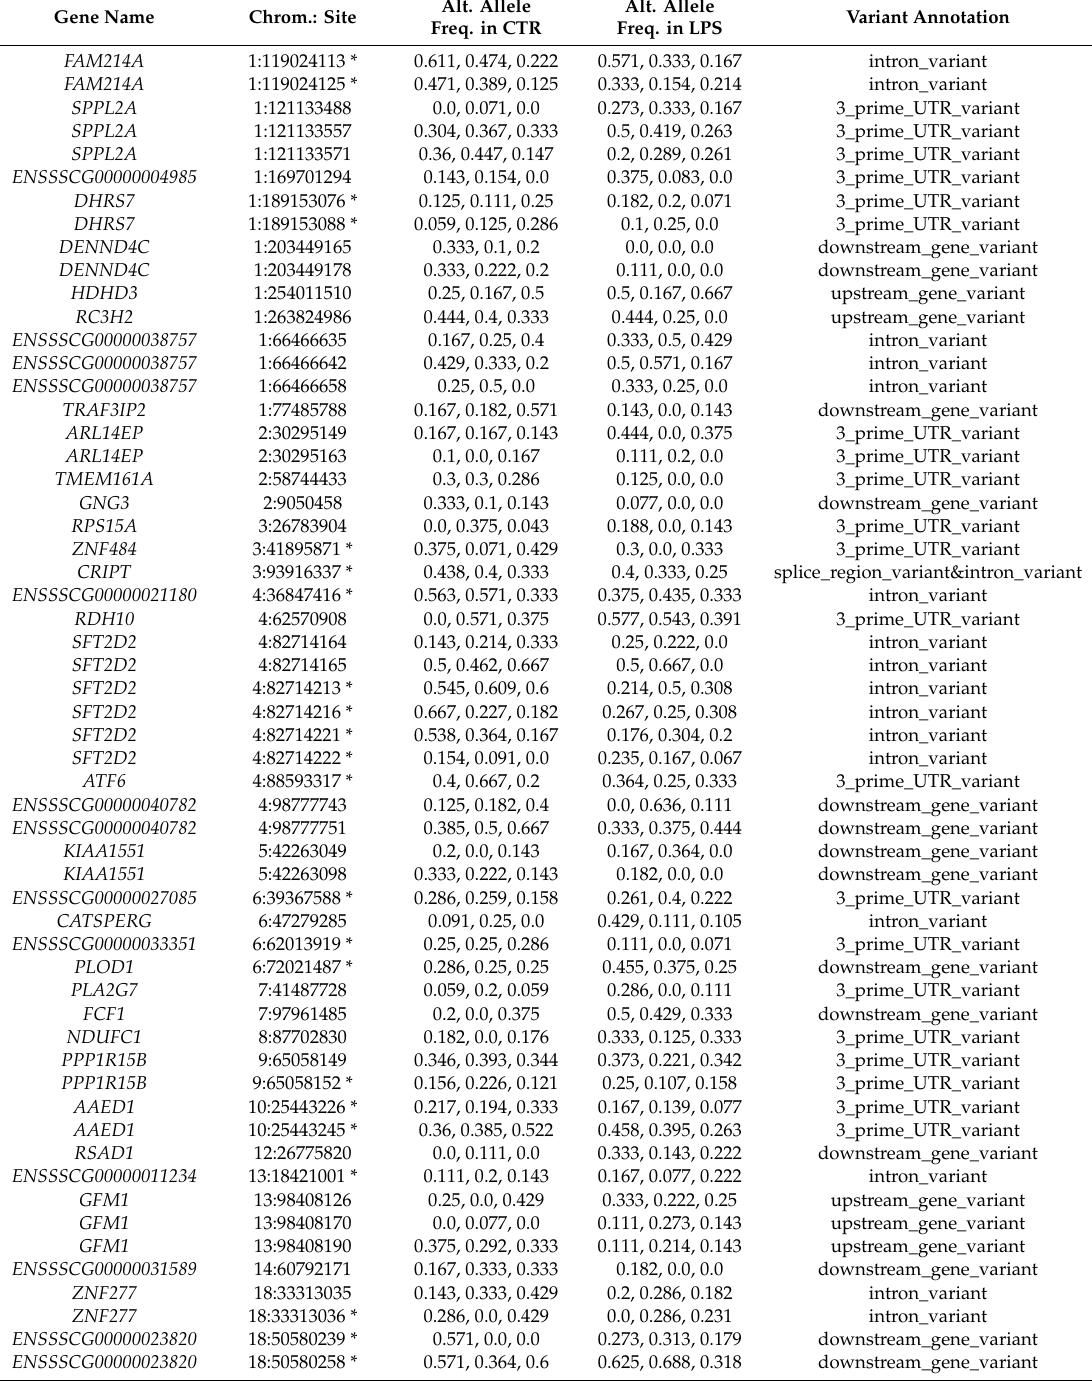
Table 3. RNA editing sites identified in the porcine SINE regions expressed in the endometrium. Star (*) in chromosome: site column indicates RNA editing site confirmed in DREP database. Variant annotations are described by SnpE ff